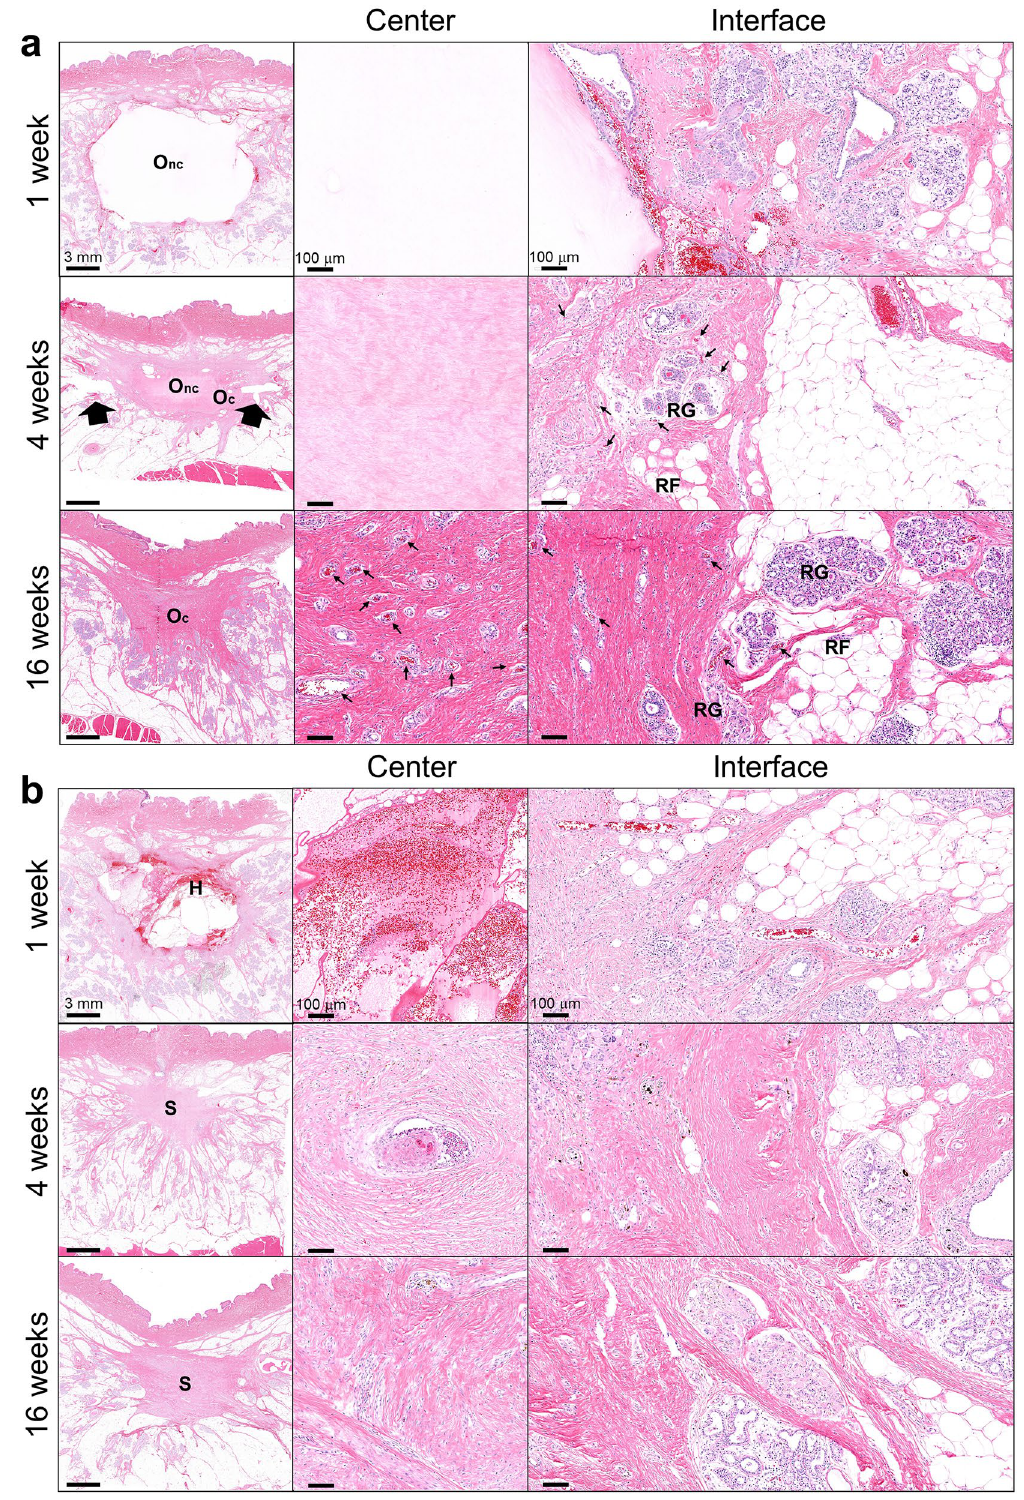
Figure 4. Collagen filler supports breast tissue neogenesis without evoking an inflammatory response. ( a ) Cross-sections (H&E) of collagen filled voids at 1 week, 4 weeks, and 16 weeks following simulated lumpectomy. Low magnification images show treated voids and their interface with the surrounding host tissue (large arrows indicate surgical clip sites). High magnification images feature the central region of the collagen filler and the filler/host tissue interface. Cellular infiltration, vascularization, and site-appropriate tissue generation of the scaffold occur over time. By 16 weeks, the collagen is completely cellularized and vascularized (small arrows indicated blood vessels) with evidence of regenerated mammary gland (RG) and adipose tissue (RF). O nc : oligomer scaffold with no cell infiltration, O c : oligomer scaffold with cellular infiltrate. ( b ) Cross-sections (H&E) of untreated (no fill) surgical voids at 1 week, 4 weeks, and 16 weeks following simulated lumpectomy. Low magnification images show voids and the surrounding host tissue. High magnification images feature the central region of the voids and the void/host tissue interface. Hematomas (H) were commonplace at 1 week, followed by progressive defect contraction and scar tissue formation